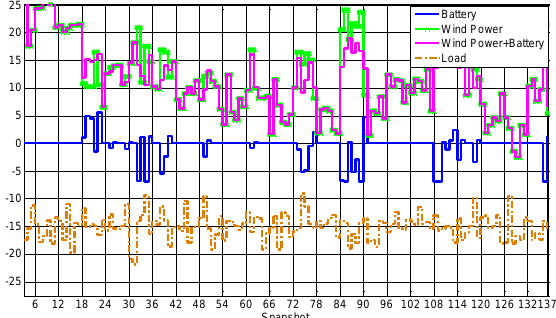
Fig.5 . Test system. Low data redundancy (